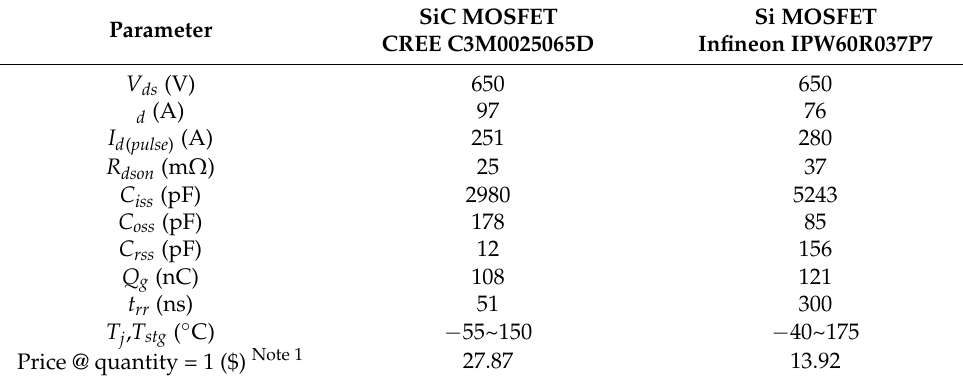
Table 4. Main electrical characteristics of power devices.